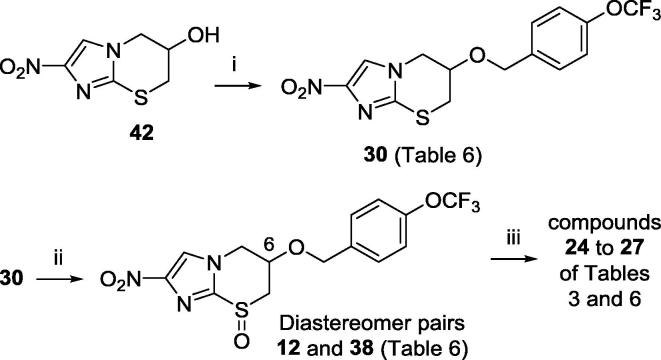
Reagents and conditions: (i) 4-OCF3BnBr, NaH, DMF, 20 °C, 160 min (93%); (ii) m-CPBA, Na2HPO4, CH2Cl2, −10 to 20 °C, 19 h (12: 75%, 38: 20%); (iii) preparative chiral SFC (see text).